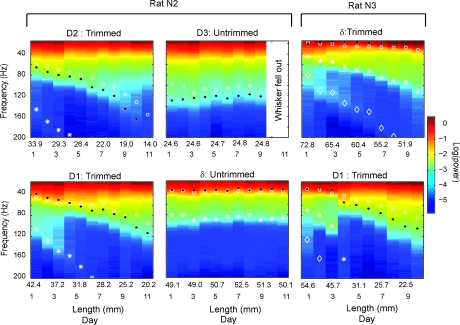
Whisker Trimming Causes Power Spectra during Whisking in Air to Shift Systematically to Higher FrequenciesPower spectra for whisker motion in air (colored vertical bars) measured daily in two animals during progressive whisker trimming. Rat N2 had the D1 and D2 whiskers trimmed approximately 2 mm per day. Rat N3 had the δ and D1 whiskers trimmed 2–4 mm per day. The D3 and δ whiskers of rat N2 remained untrimmed. Open circles, whisker FRF measured daily by the impulse method. Asterisks and diamonds, first and second harmonics of the measured FRF calculated using the truncated cone model of the whisker. Black dots are the calculated first shoulders of the power spectra (see Figure 3). Whisker length was measured daily, but for clarity, only alternate days' measurements are shown in the figure.